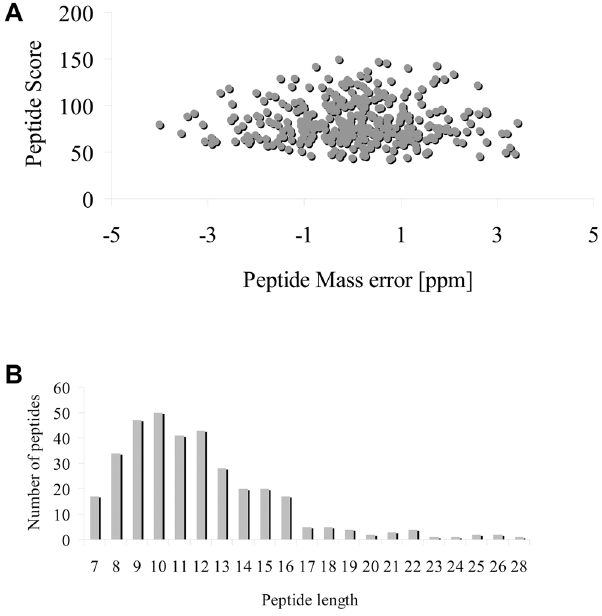
Fig 1. Evaluation of the quality of MS and MS/MS data. (A) Peptide score of all succinylated peptides is plotted as a function of calibrated peptide mass errors measured from all identified peptides in parts-per- million (ppm). (B) Length distribution of the identified